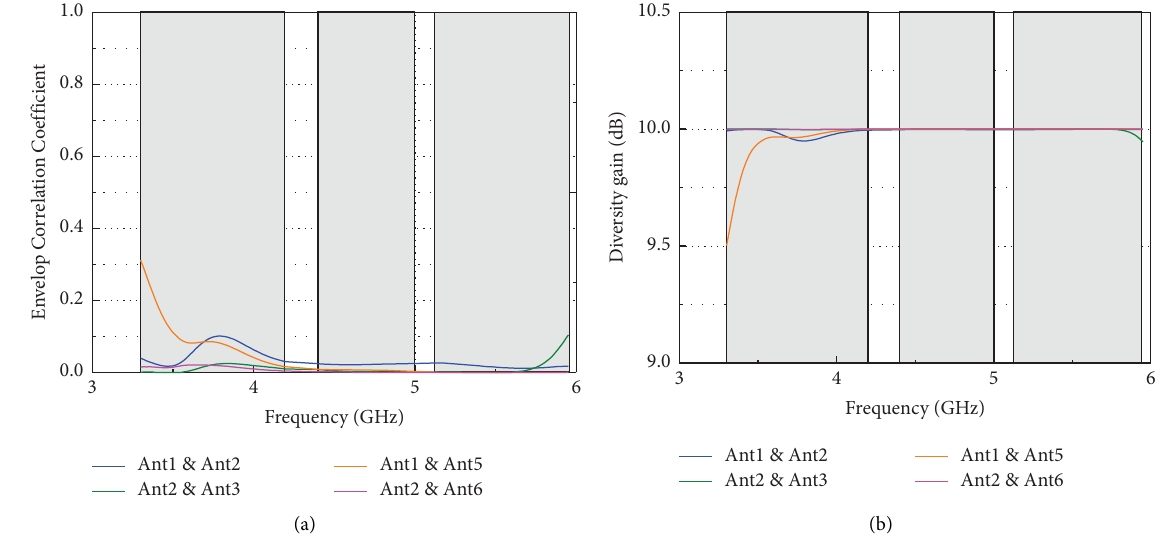
Figure 11: (a) Simulated ECCs and (b) diversity gains. Table 1: Comparison with previously published